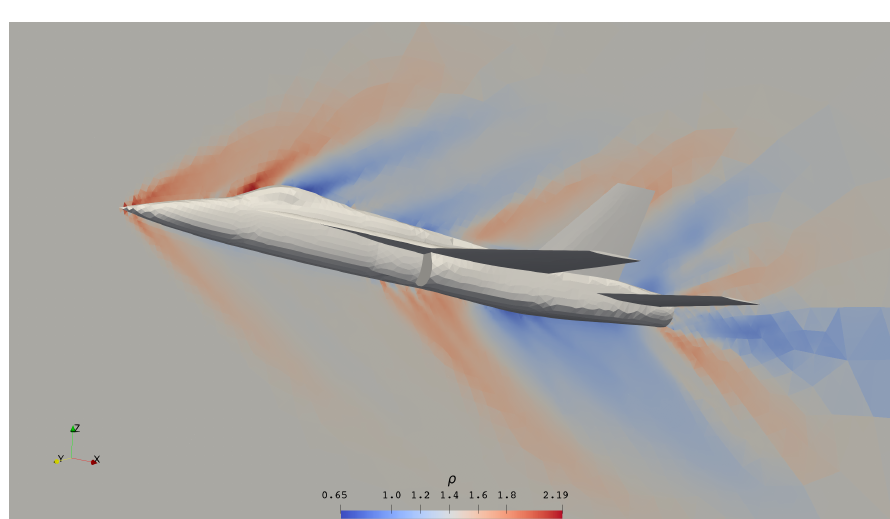
Figure 25. Density contour obtained from the third-order solution of Problem 6.